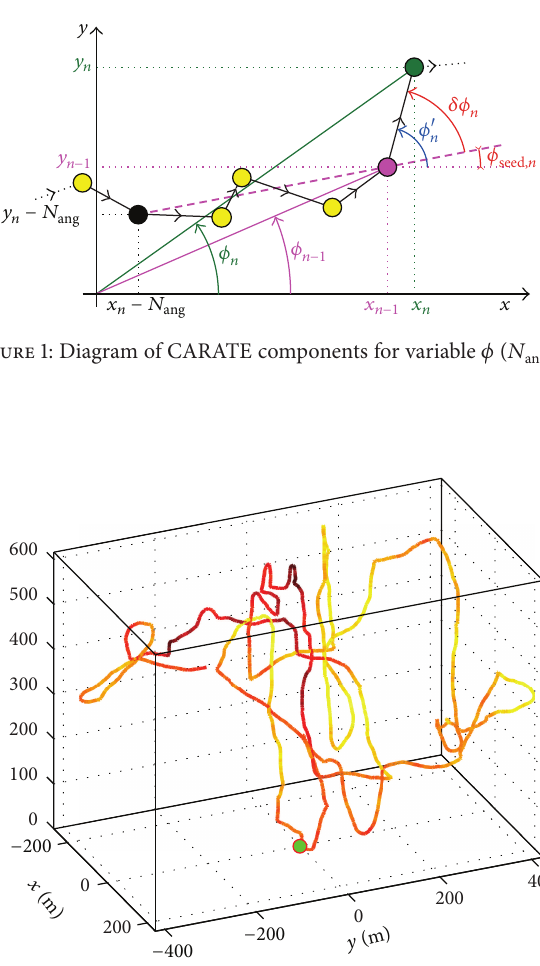
Figure 2: Example of UAV 3D trajectory generated with